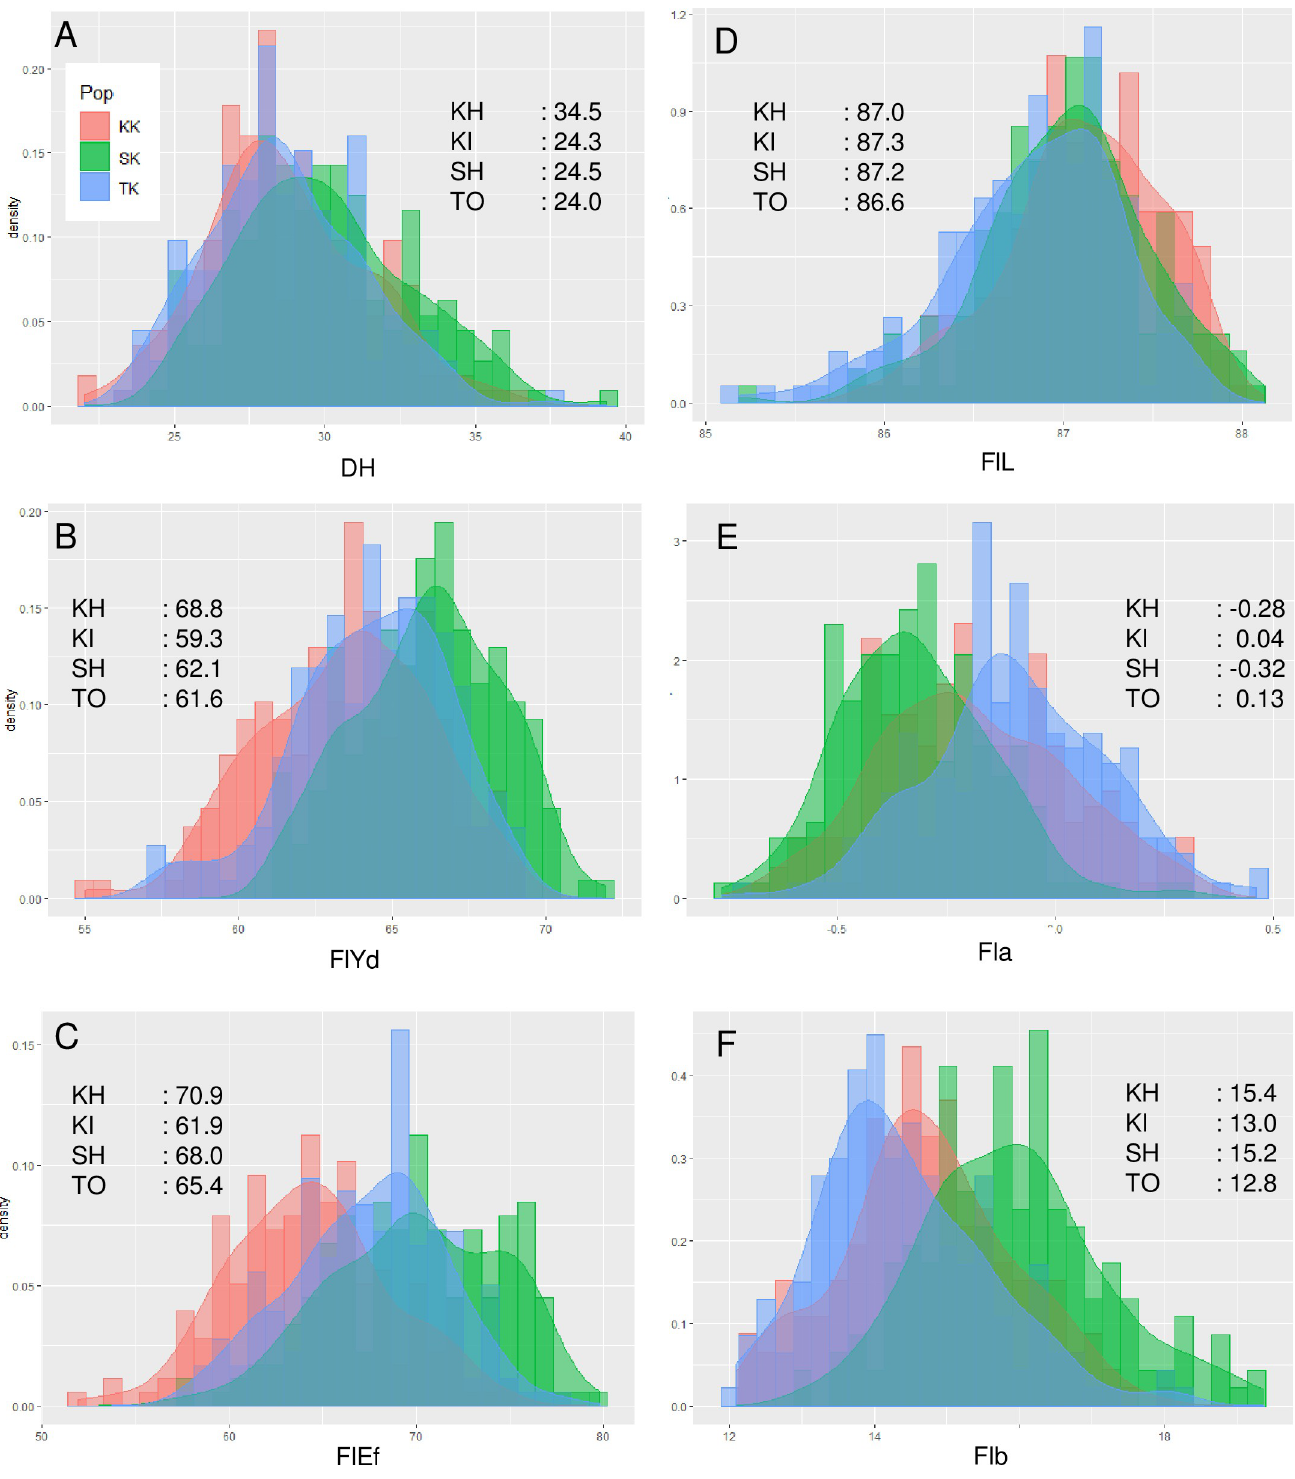
Fig 1. Distributions of least square means across environments. (A) DH: days to heading, (B) FlYd: flour yield, (C) FlEf: flour efficiency, (D) FlL: flour color L � , (E) Fla: flour color a � and (F) Flb: flour color b � . KH: Kitahonami, KI: Kinuhime, SH: Shunyou, TO: Tohoku224.